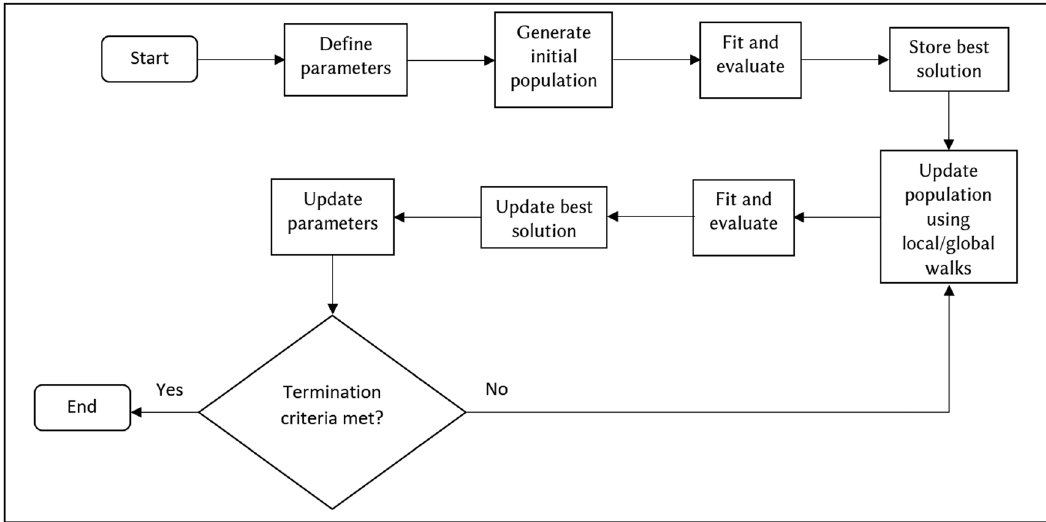
Figure 1: A generalized metaheuristic algorithms fl owchart for the 1D